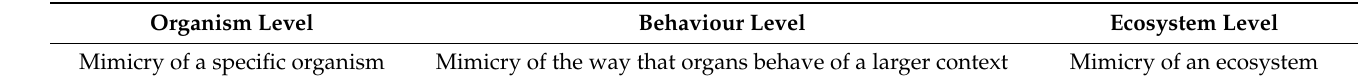
Table 1. Framework for different levels of